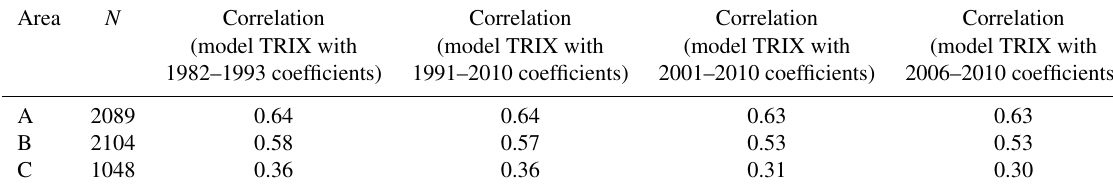
Table 3. Pearson’s correlation values between in situ TRIX and the TRIX calculated from model simulations ( p value < 0.01 for all the periods and areas). For model TRIX U i and L i values from different time series were considered: 1982–1993 (model TRIX), 1991–2010